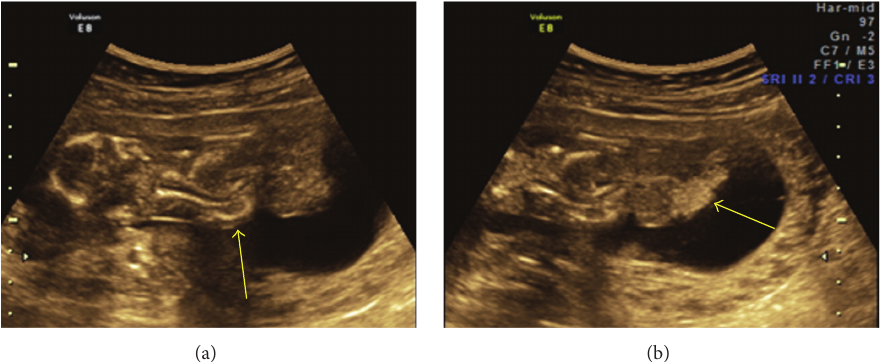
Figure 4: (a) Arrow indicates kyphoscoliosis. (b) Herniation of liver and bowel loops noted in extra embryonic coelomic cavity.